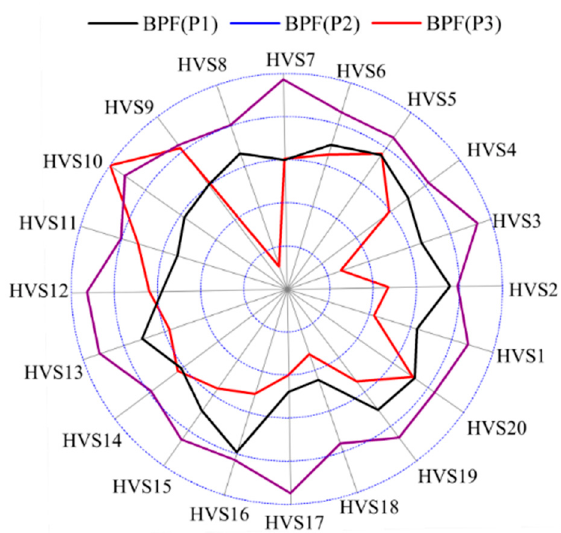
Figure 20. Pressure fluctuation components of BPF at different circumferential locations at P1, P2 and P3 operating points with 9 impeller blades.